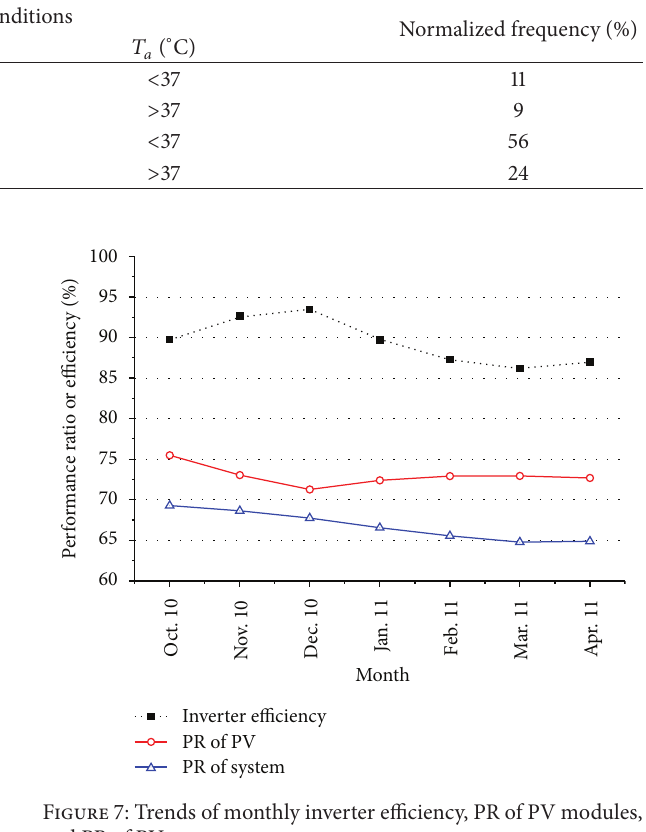
1000 W/m 2 , module temperature of 25 ∘ C, and air mass